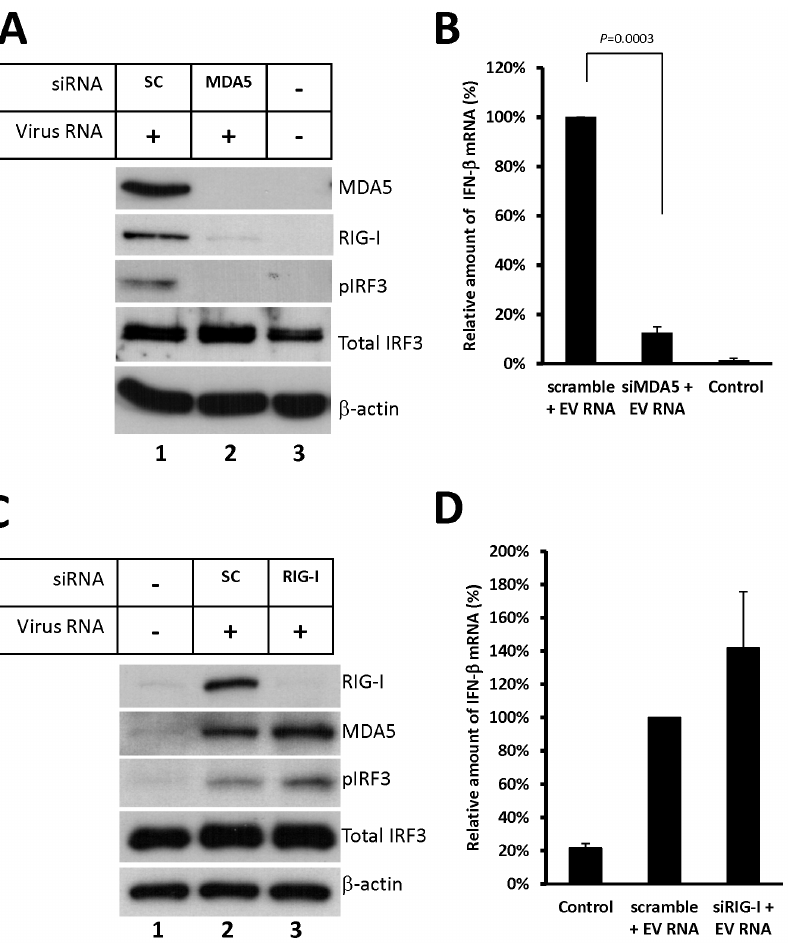
Figure 4. MDA5 plays a crucial role in EV71 RNA-mediated IRF3 activation. (A) HeLa cells were transfected with siRNA against MDA5 or scrambled siRNA for 6 h, followed by transfection with EV71 RNA for 24 h. Extracts from the transfected cells were collected, and the expression of MDA5 and RIG-I was analyzed by immunoblotting using an anti-MDA5 or anti-RIG-I antibody. IRF3 activation was assayed by immunoblotting using anti-phospho-IRF3 and anti-total-IRF3 antibodies. (B) Total RNA was isolated from the transfected HeLa cells. Relative amount of the IFN- b mRNA was measured using real-time RT-PCR. (C) HeLa cells were transfected with scrambled siRNA or siRNA against RIG-I for 24 h, followed by transfection with EV71 RNA for 20 h. Cell extracts and total RNA were collected from the transfected HeLa cells. The expression of RIG-I, MDA5, phosphorylated IRF3, total IRF3, and b -actin was detected by immunoblotting. (D) Relative amount of IFN- b mRNA in RIG-I knockdown cells was measured by real-time RT- PCR.